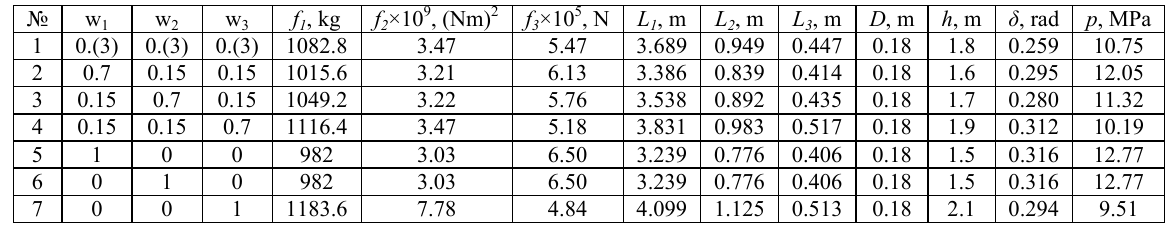
Table 8. Compromise solutions for different weighting